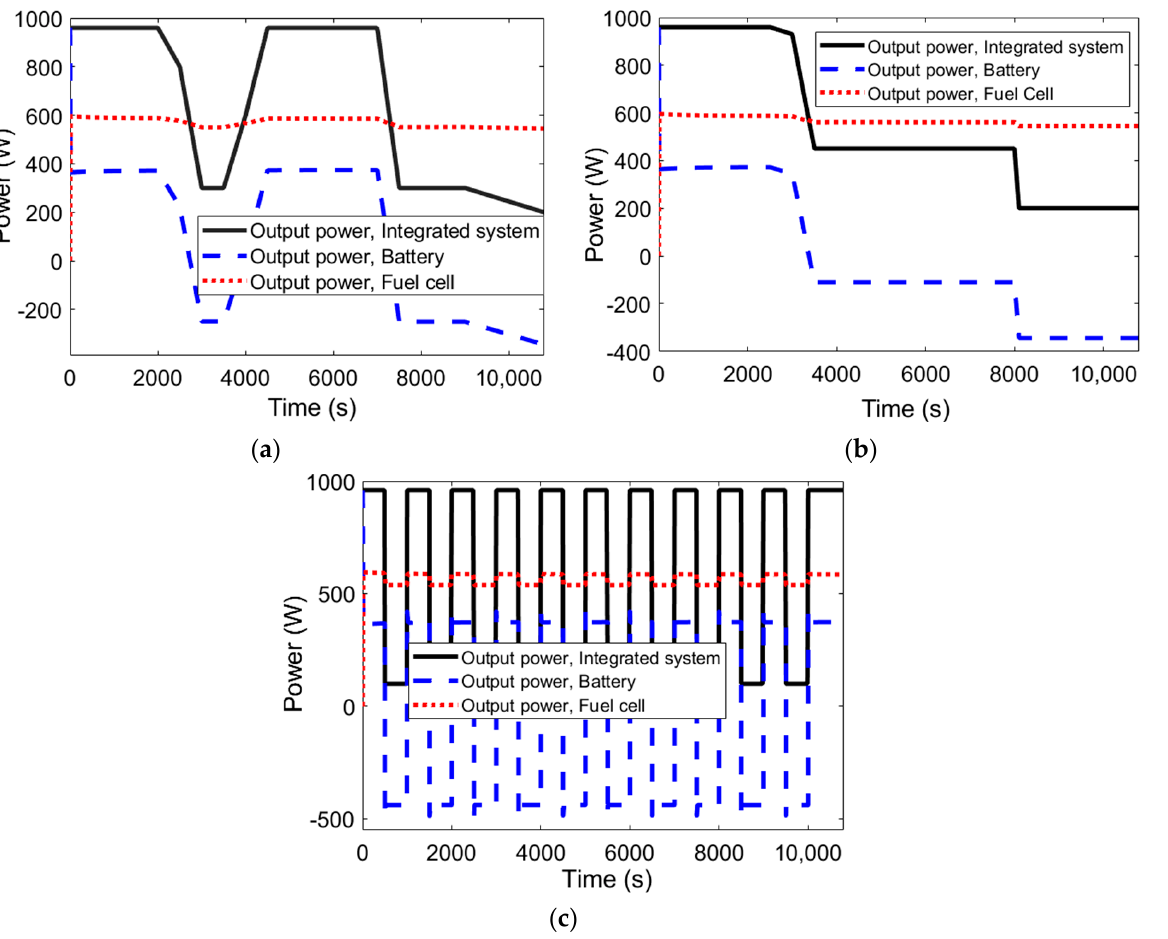
Figure 4. The overall output power of the integrated system, differentiating the shares of the fuel cell and battery: ( a ) case 1, ( b ) case 2, and ( c ) case 3.